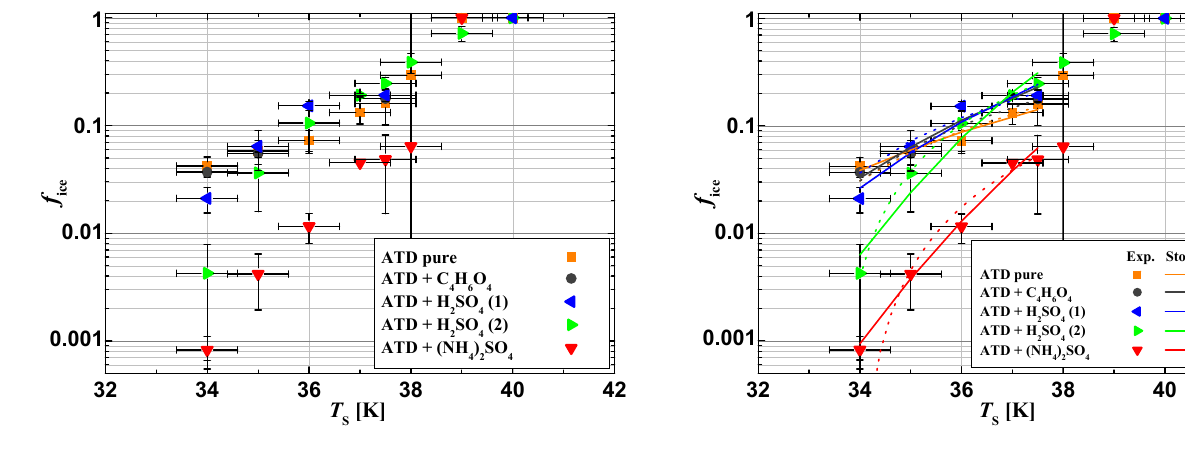
Fig. 9. Immersion freezing behavior of all examined types of parti- cles. The determined f ice and the parameterization curves of both approaches are plotted (see Eqs. 8 and 11 together with 12). The line at T s =38K separates the heterogeneous (on the left) and homo- geneous (on the right) freezing